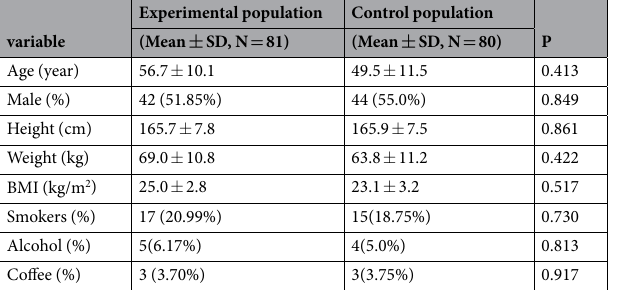
Table 1. Clinical characteristics of hypertensive subjects and normal subjects. SD, standard deviation; BMI, body mass